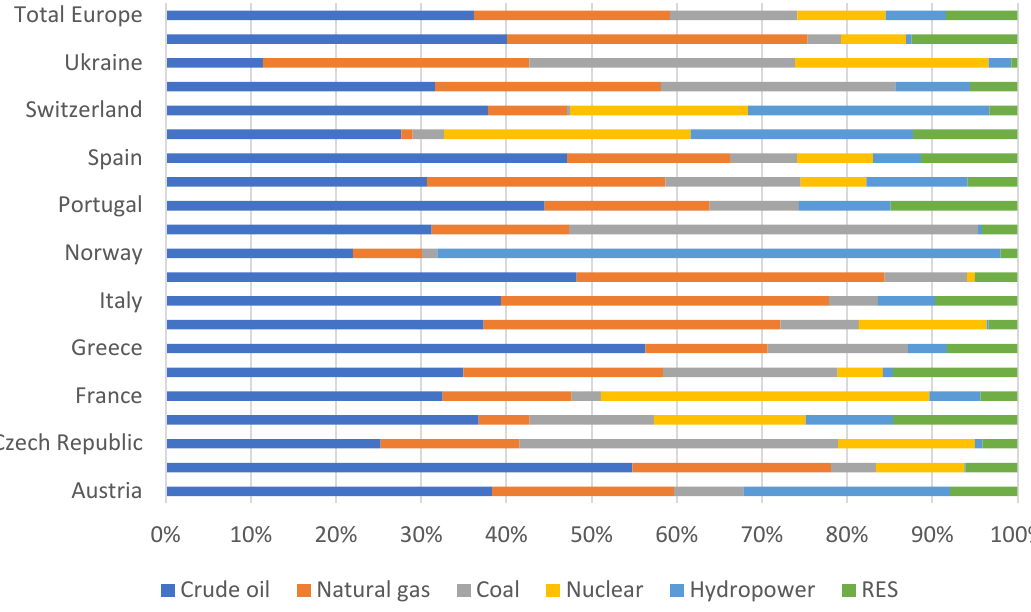
Figure 2. The structure of the energy mix of the European countries, own elaboration.